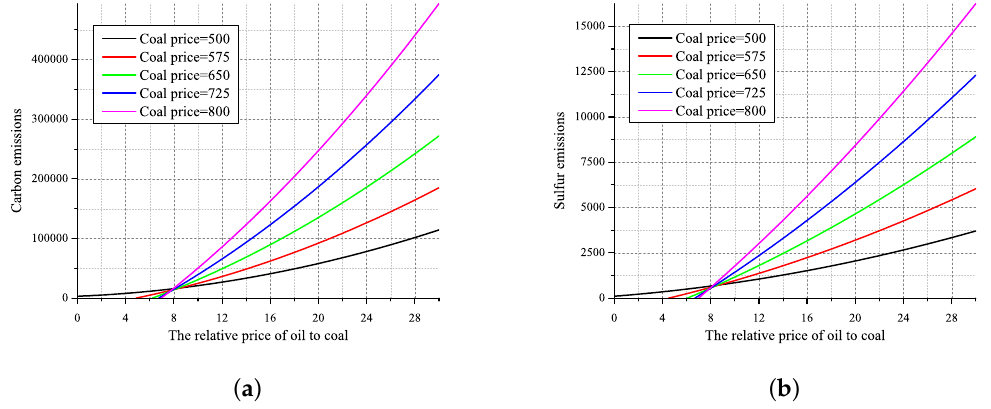
Figure 7. ( a ) Cross-sectional views of W 1 with coal price P 1 between 500–800; ( b ) Cross-sectional views of W 2 with coal price P 1 between